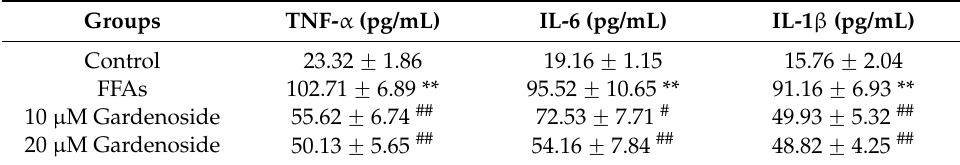
Table 1. Effect of Gardenoside on inflammatory cytokines in HepG2.